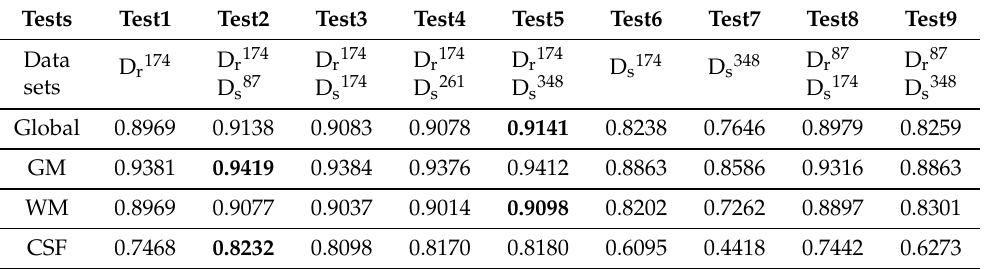
Table 4. Segmentation of Grey Matter (GM), White Matter (WM), and CerebroSpinal Fluid (CSF) dice score, where r refers to real and s refers to synthetic scans. If two datasets are included in the same test, this means that the test was performed with the union of both datasets. The best results are in bold.